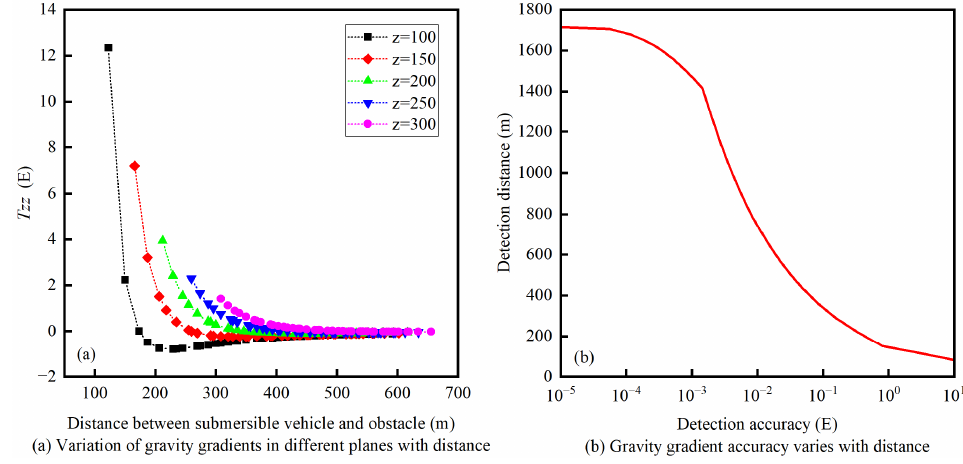
Figure 5. The relationship between detection accuracy and detection distance.